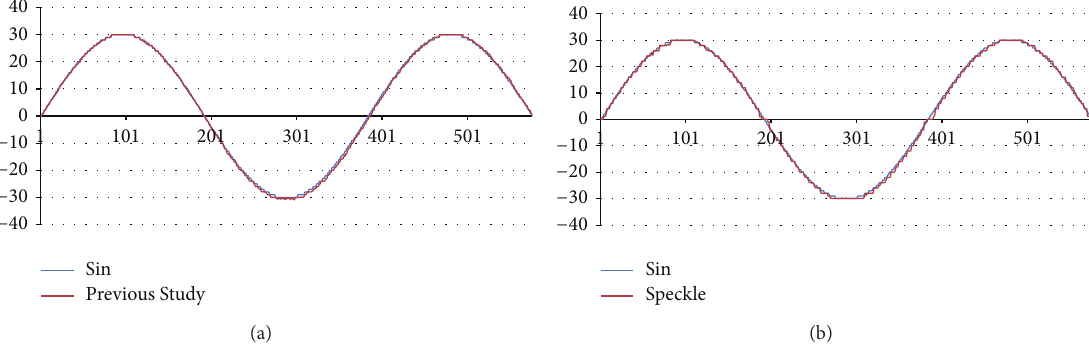
Figure 10: Numerically simulated time history of displacement. (a) Hive triangle pattern and (b) random